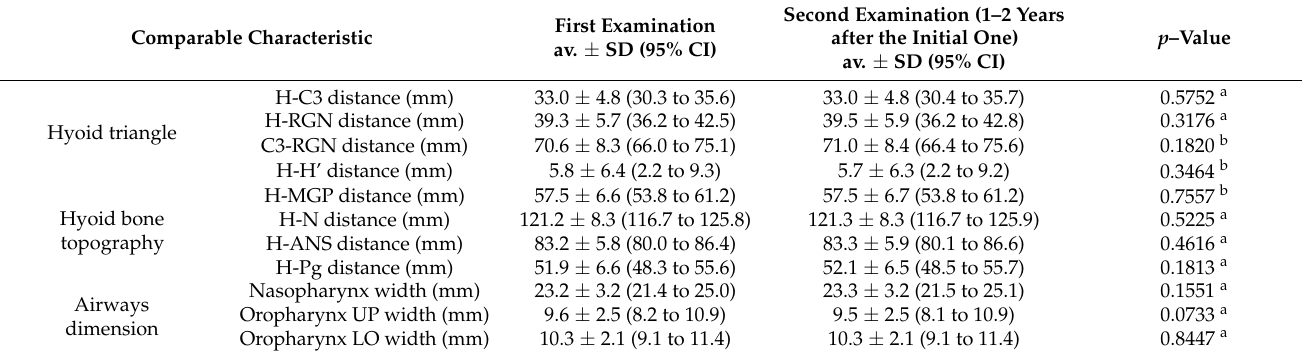
Table 3. Assessment of the changes in the hyoid bone position and the width of nasopharynx and oropharynx that occurred between the first and the second orthodontic examination in the control